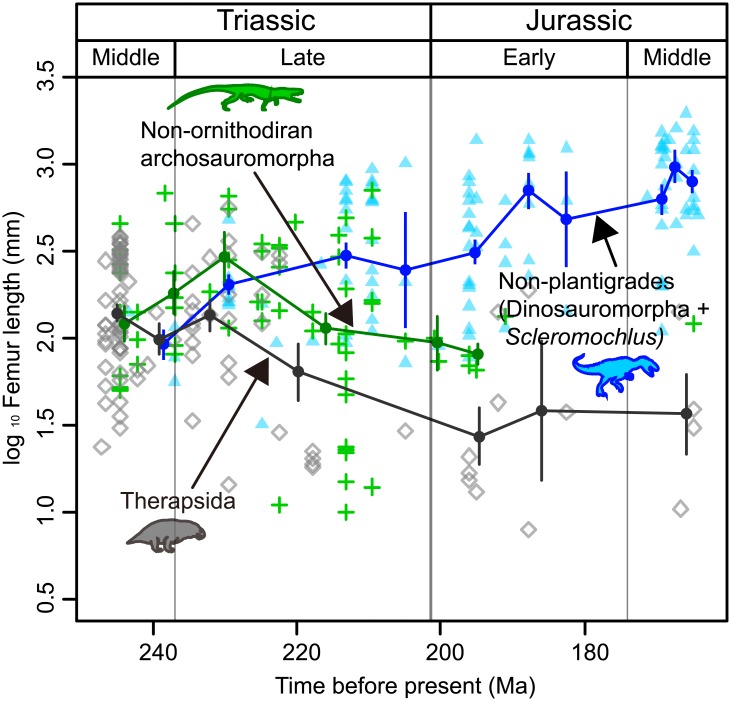
Femur length of terrestrial nonplantigrade and plantigrade lineages from the Middle Triassic to Middle Jurassic.Log femur length was plotted against the midpoint of the geological age estimated for each taxon. Mean and variance of femur length in each time bin are plotted. These values were used to fit evolutionary models (S9 Table). A trend toward longer femur length, reflecting a larger body size, was found in the nonplantigrade lineage (dinosauromorphs and Scleromochlus, blue triangle), whereas no directional trend was observed in plantigrade lineages (nonornithodiran archosauromorphs, green crosses; therapsids, gray diamonds).